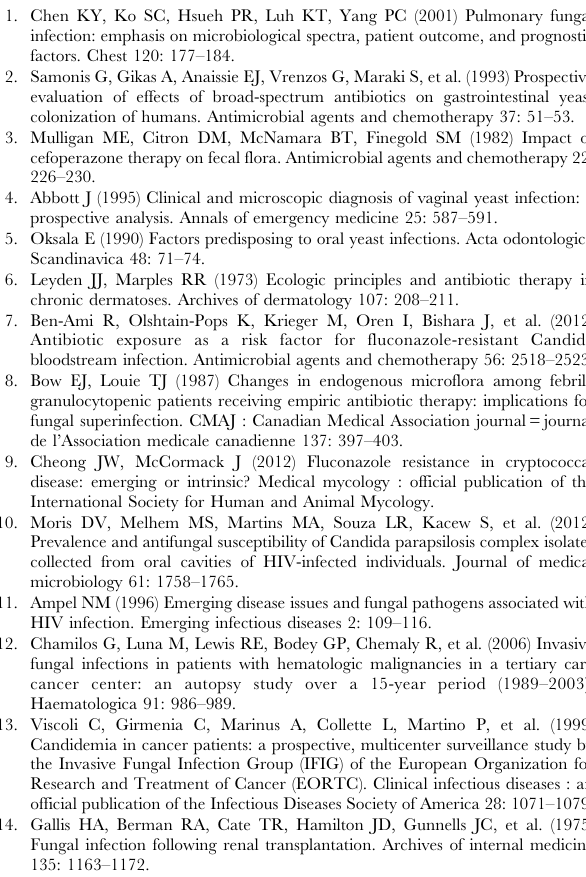
Table S2 Fungal lineages detected in this study and statistical analysis of longitudinal changes. Each time course was separated into intervals, and species abundance was compared between the time intervals indicated in the column headings. Mean values were compared for each lineage using the Friedman test (non-parametric with repeated measures). p-values that survived Bonferroni correction are highlighted and bolded.